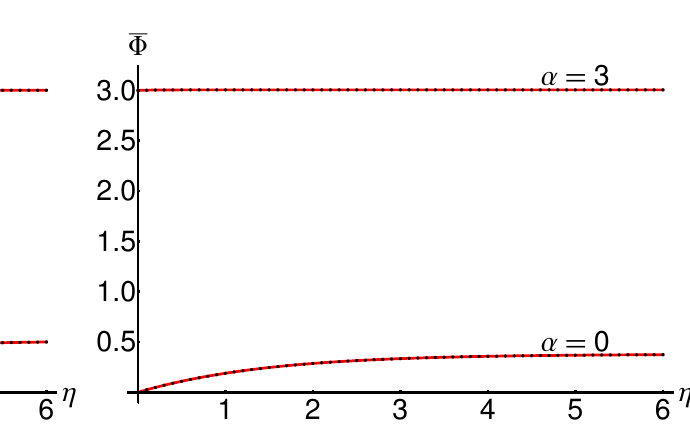
Figure 8: Variation of Φ by increasing the coeflcient α for axisym- metric flow ( m = 2, λ = 1) :